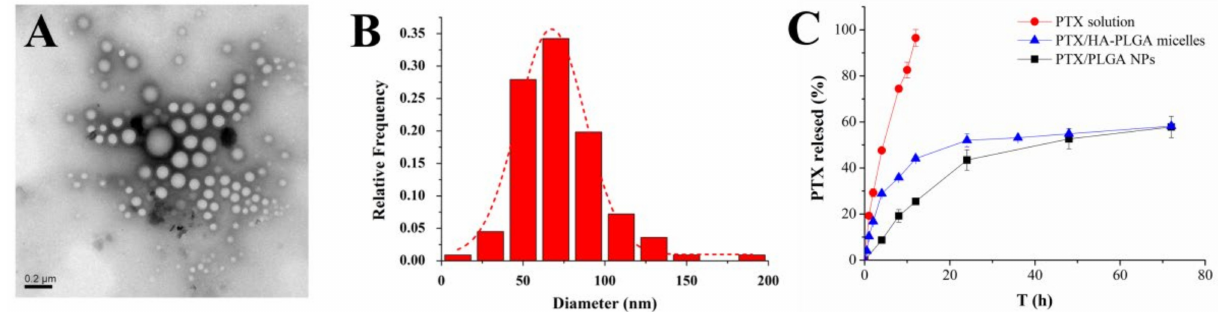
Figure 1. ( A ) TEM image of PTX/HA-PLGA micelles. ( B ) Particle size distribution curve based on TEM results. ( C ) In vitro release of PTX/HA-PLGA micelles, PTX/PLGA NPs, and PTX solution. 2.2. Endocytosis Pathways and Cytotoxicity of PTX/HA-PLGA Micelles Flow cytometry results demonstrated that both MSCs and C6 cells were positive for CD44 (Figure S1). HA-modified micelles significantly enhanced the cellular uptake via HA-CD44 interaction (Figure 2A). The fluorescence of the coumarin 6/HA-PLGA micelles-treated group was higher than its counterpart (coumarin 6/PLGA NPs). The significantly reduced uptake after competitive treatment with free HA confirmed that HA-PLGA micelles were efficiently internalized by receptor-mediated endocytosis in CD44 over-expressing cells.